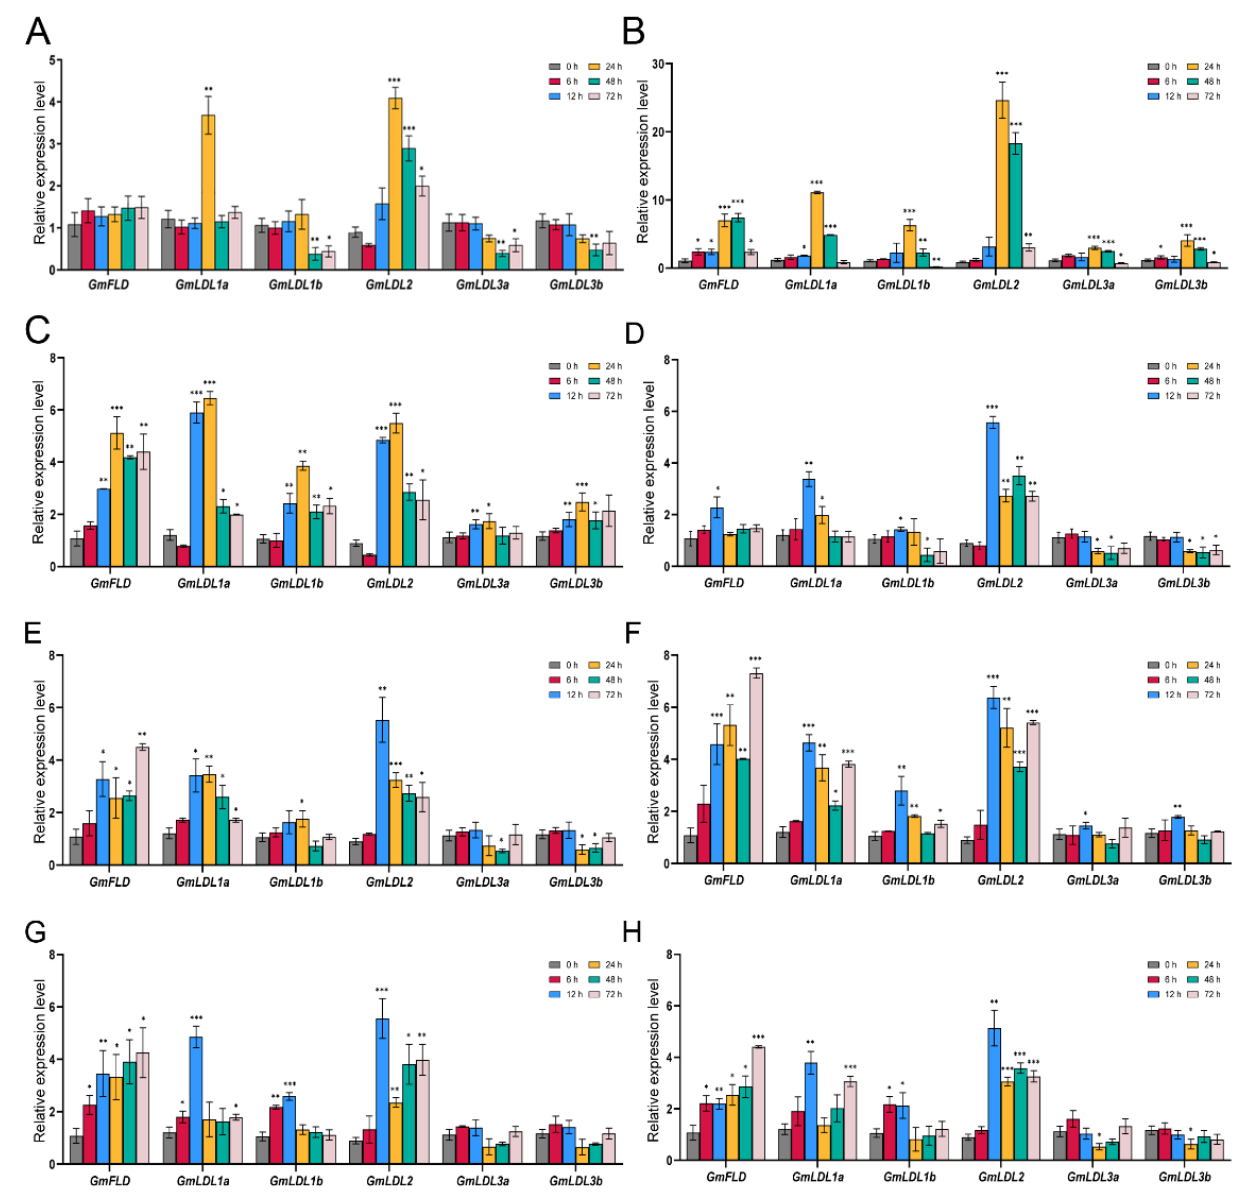
Figure 4. Expression patterns of GmLDL genes under different abiotic stresses. Two-week-old soybean seedlings were exposed to stress treatments as indicated below. Gene expression analysis was conducted by qRT-PCR using gene-specific primers. ( A ) Shade stress, ( B ) heat stress, ( C ) cold stress, ( D ) drought stress, ( E ) flooding stress, ( F ) salt stress, ( G ) low Pi stress, ( H ) low N stress. The mean values are from three independent biological replicates. Statistical analyses were performed by Student’s t -test (* p < 0.05, ** p < 0.01 and *** p < 0.001).